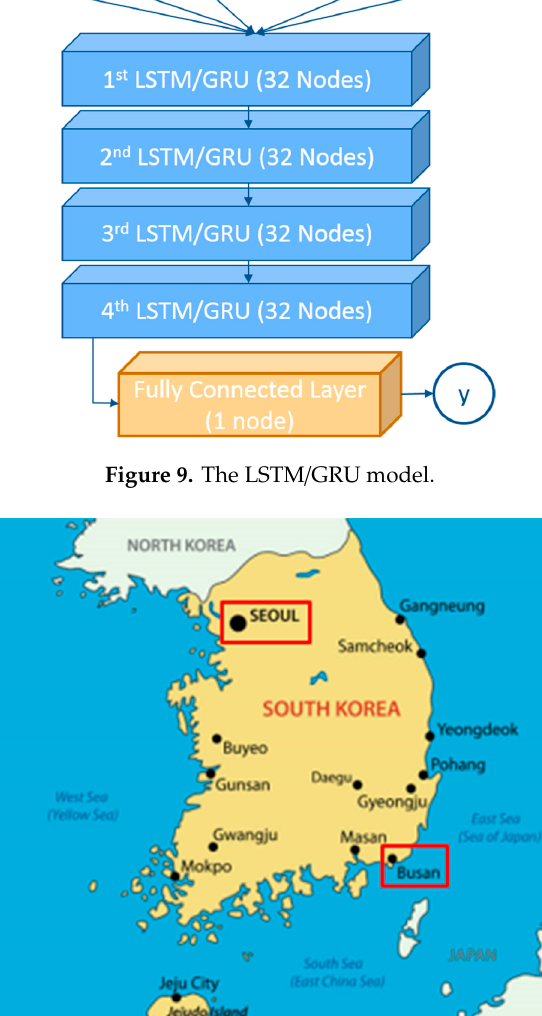
Figure 10. Geographical difference of the two selected regions. Table 2. RMSE of hourly solar radiation for di ff erent